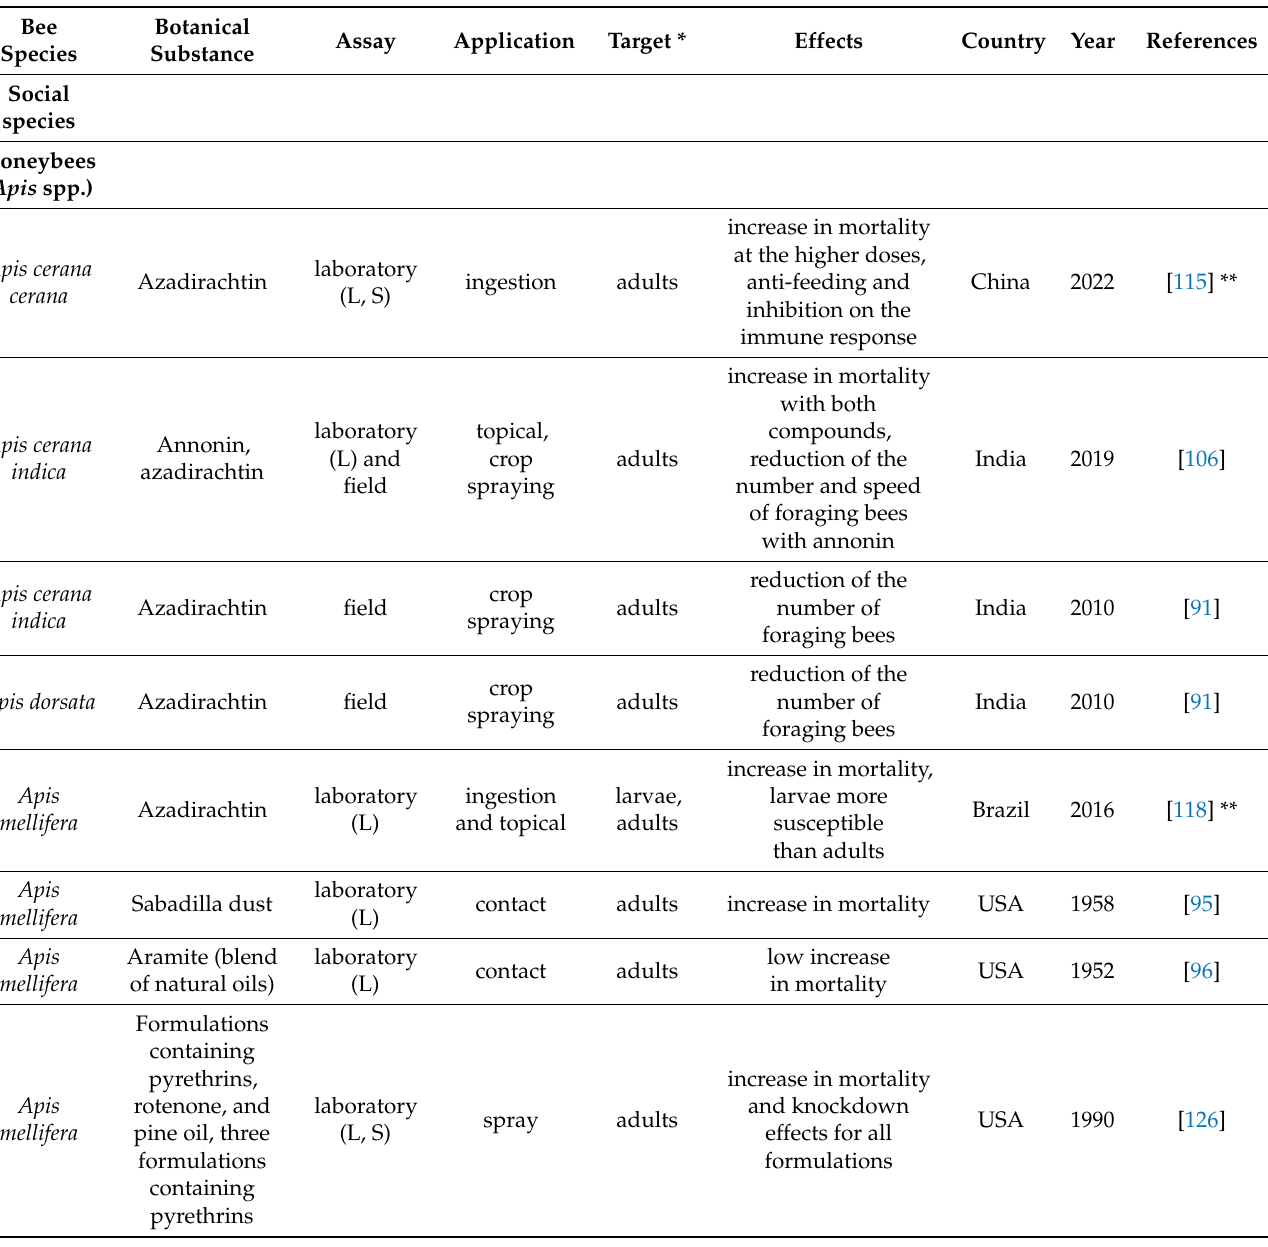
Table 1. Laboratory, semi-field, and field studies testing the lethal (L) and sublethal (S) effects on social and solitary bees (Hymenoptera, Apoidea) of botanical